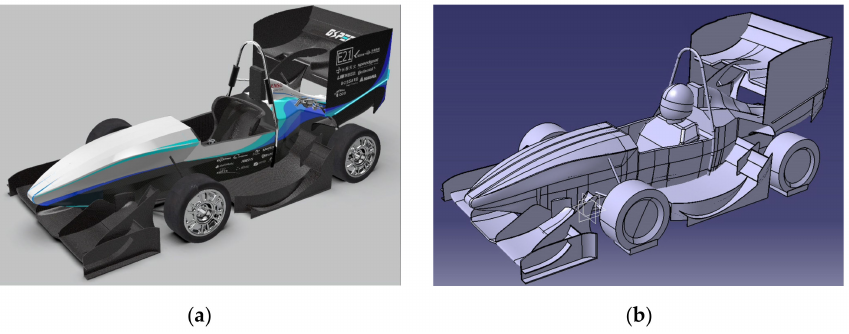
Figure 9. Comparison between the original CAD model (left) and simplified one (right). ( a ) Original CAD model includes considerable details that are mostly meaningless for CFD simulation, such as powertrain inside monocoque and some small electronic devices; ( b ) simplified model contains merely aerodynamic kits, monocoque, and some other indispensable parts, such as the driver and front